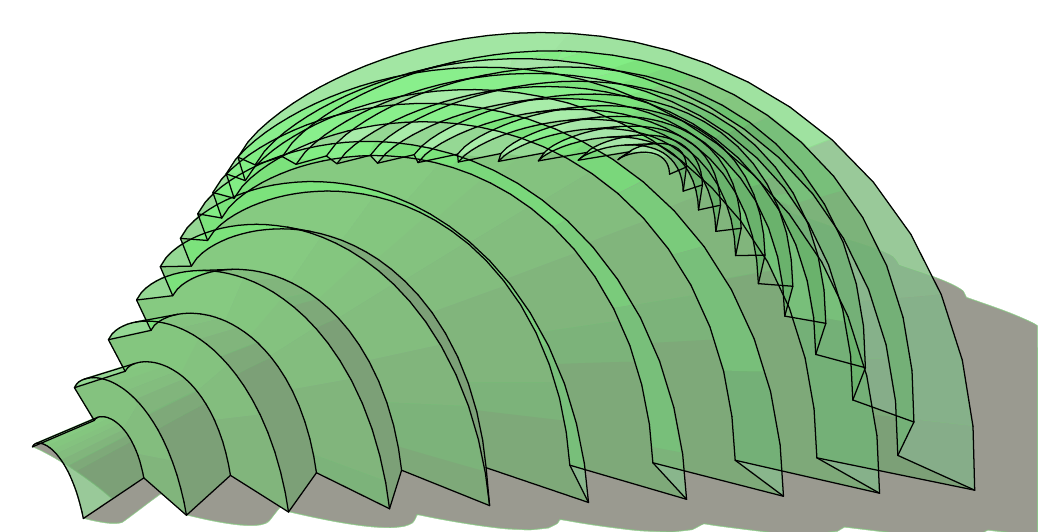
Figure 11. A corrugated form of method